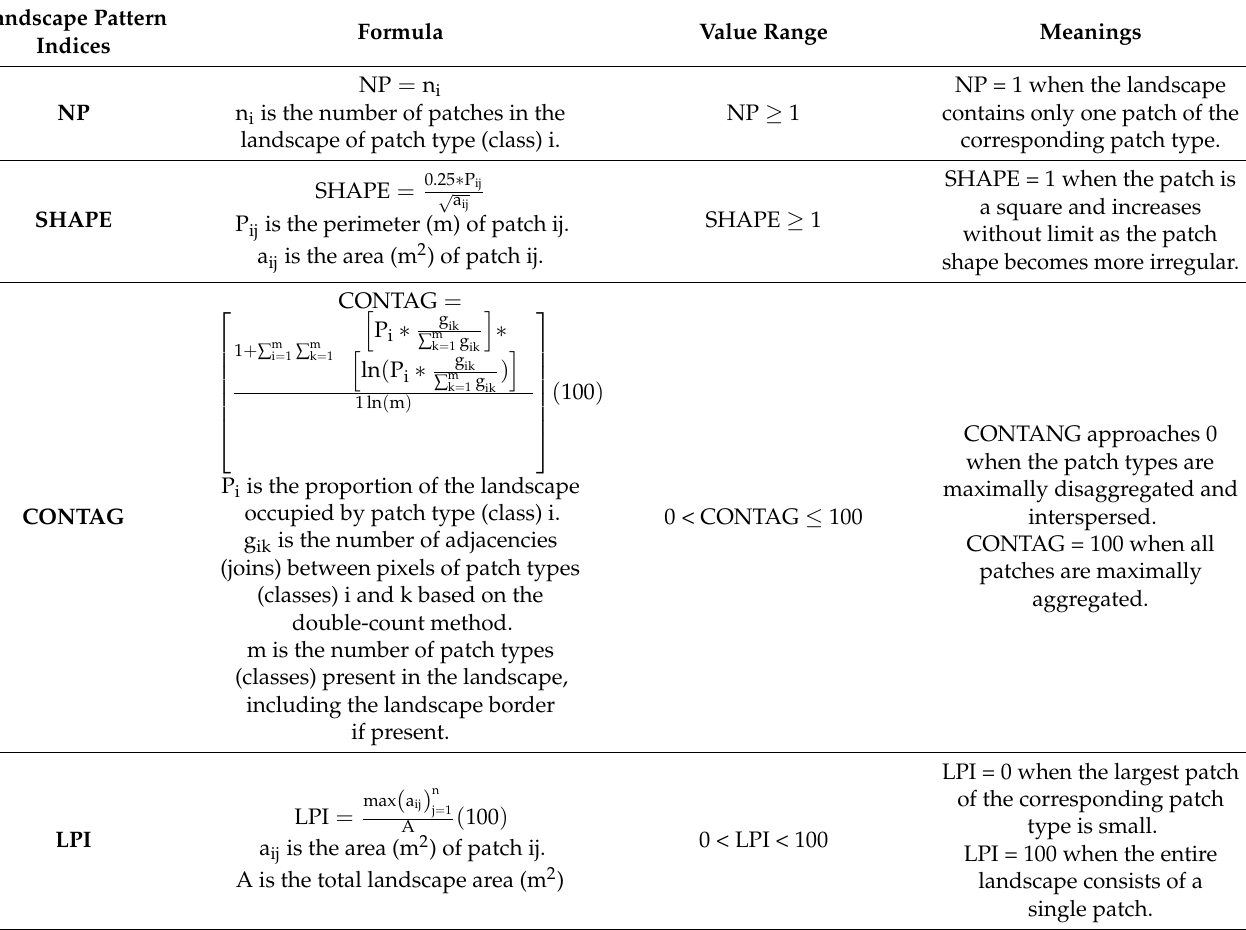
Table 2. Description of the selected landscape pattern